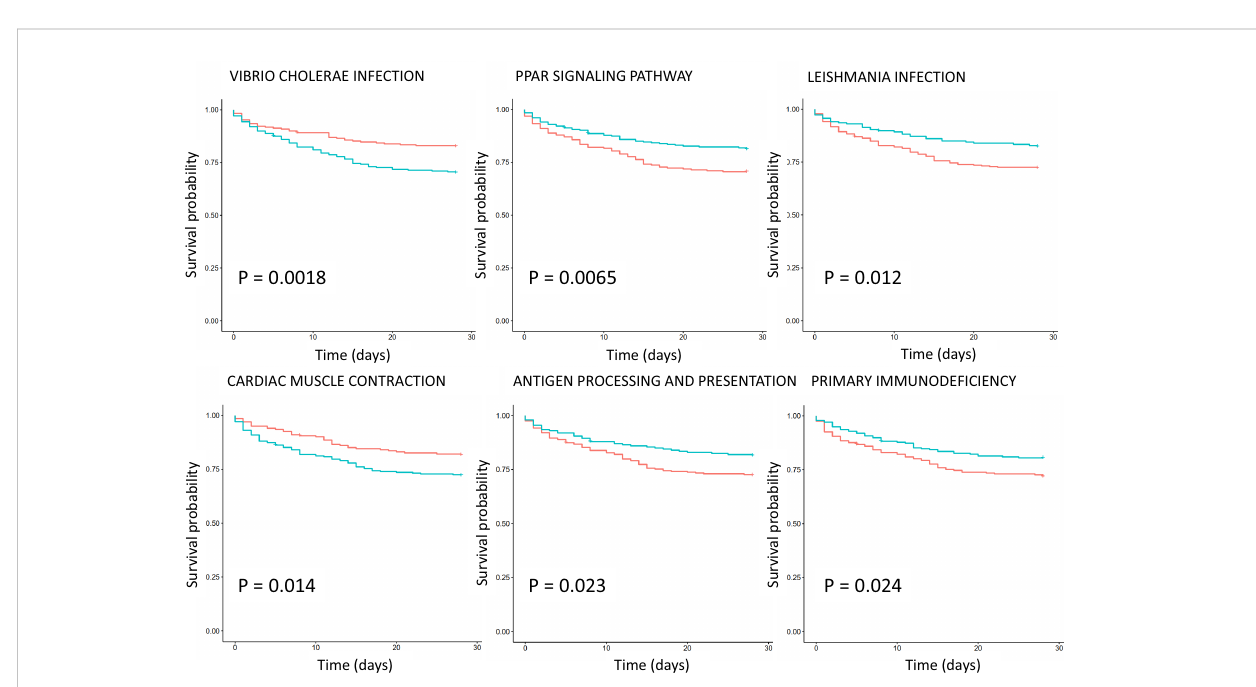
FIGURE 3 Survival analysis of KEGG pathway expression in severe sepsis patients based on dataset GSE65682. The red curve represents the pathway with low expression, and the green curve represents the pathway with high expression. The P value is obtained according to the log-rank test, and the top 6 pathways with the most signi fi cant P value are